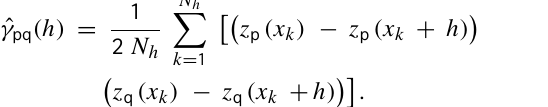
Fig. 3. Two examples of an experimental variogram (black circles) and the fitted spherical variogram model (red curve) of square-root transformed rain gauge observations on 22 December 2002 for two consecutive hours ( A and B ). (C) Experimental cross-variogram (circles) and fitted spherical cross-variogram model corresponding to (A) and (B)